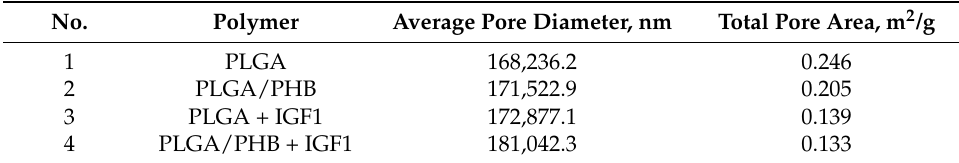
Table 5. Characteristics of porous structure of implantable